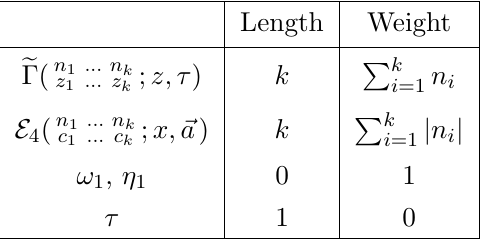
Table 1 . Length and weight of eMPLs and related constants.